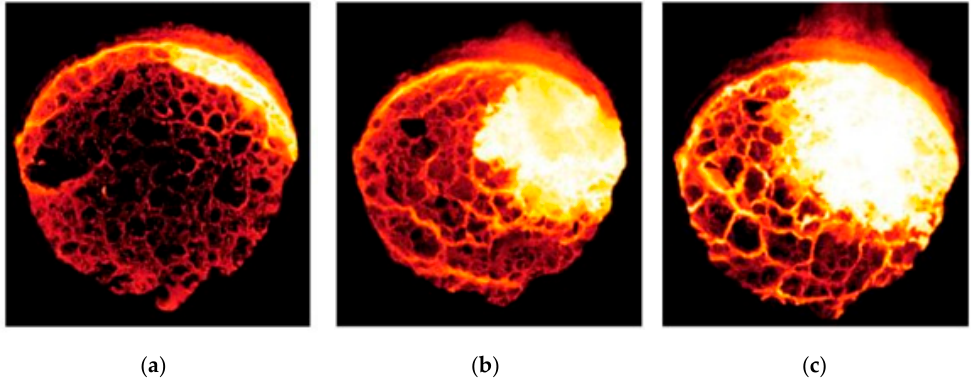
Figure 10. Open-eye size in the ladle from experimental results for a slag layer thickness of 55 cm: ( a ) Q = 200 NL/min, ( b ) Q = 400 NL/min, and ( c ) Q = 500 NL/min.